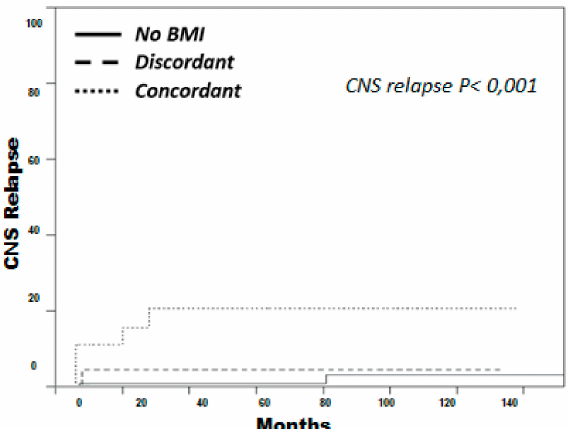
Figure 2. Cumulative incidence of central nervous system (CNS) relapse by bone-marrow infiltration type. Considering death as a potential competing risk, cumulative incidence of CNS relapse was significantly higher in the concordant group (dotted line) as compared to the discordant group (discontinuous line) and the non-infiltrated group (continuous line).